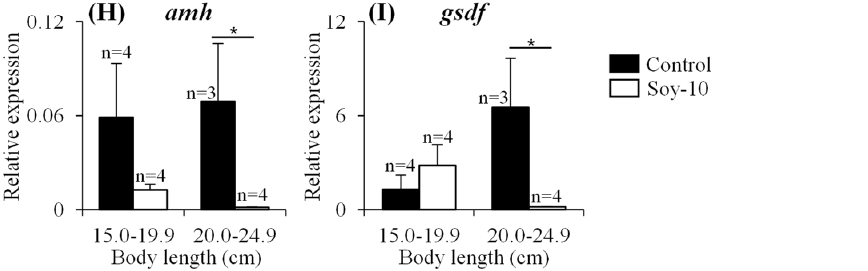
Figure 2. Histological analysis of germ cells and quantitative real-time PCR (qPCR) analysis of sex-specific genes in the gonads of Japanese eels raised to 45 days. ( A – D ) Histological sections of undifferentiated gonads after hematoxylin and eosin staining in body-length groups medium ( A , B ) and large ( C , D ). ( E – I ) Expression of sex-specific genes in the gonads of eels by qPCR analysis. Relative expression levels of the target genes were normalized against the expression of elongation factor 1 alpha ( ef1 α ): vasa ( E ), foxl2a ( F ), cyp19a1 ( G ), amh ( H ), and gsdf ( I ). * p < 0.05; ** p < 0.01; *** p < 0.001; GC, germ cell.